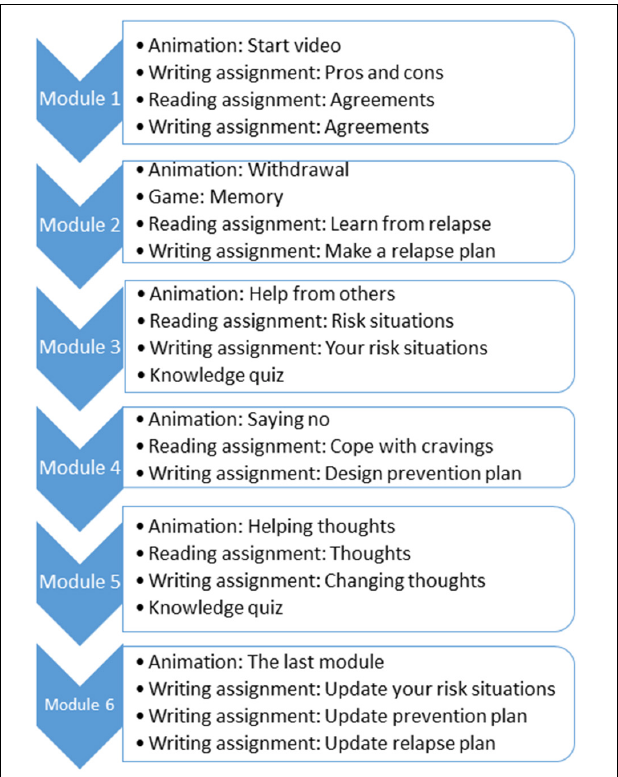
FIGURE 1 | Diagram with the activities of each module of the Jellinek intervention. Each module should last at least 5 days. During each module the participants are encouraged to register their daily